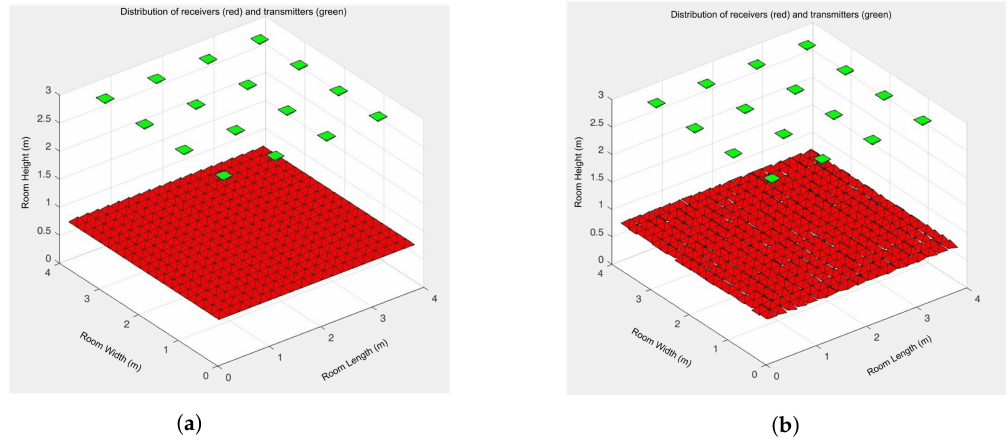
Figure 6. Receivers orientation: ( a ) each receiver points towards the ceiling with 90 ◦ ; ( b ) each receiver points towards the ceiling with a randomly